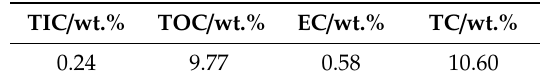
Table 2. Carbon analysis of fines; TIC = total inorganic carbon, TOC = total organic carbon, EC = elemental carbon, and TC = total